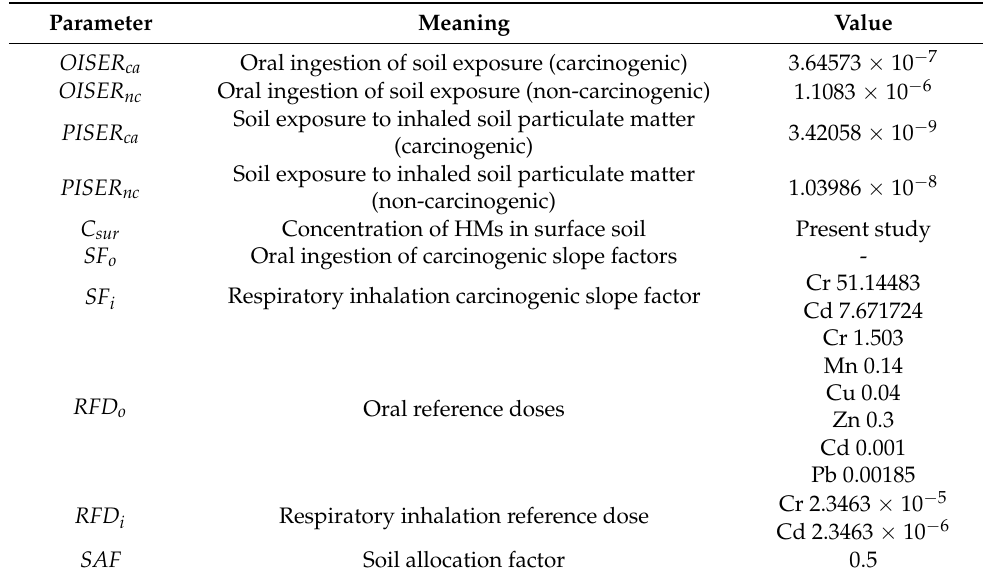
Table 4. Exposure model